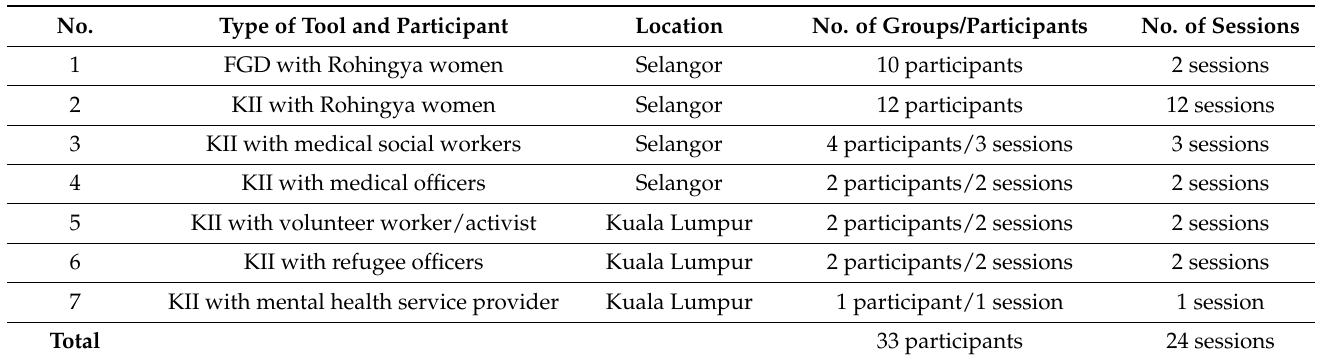
Table 1. Types and number of participants and interview